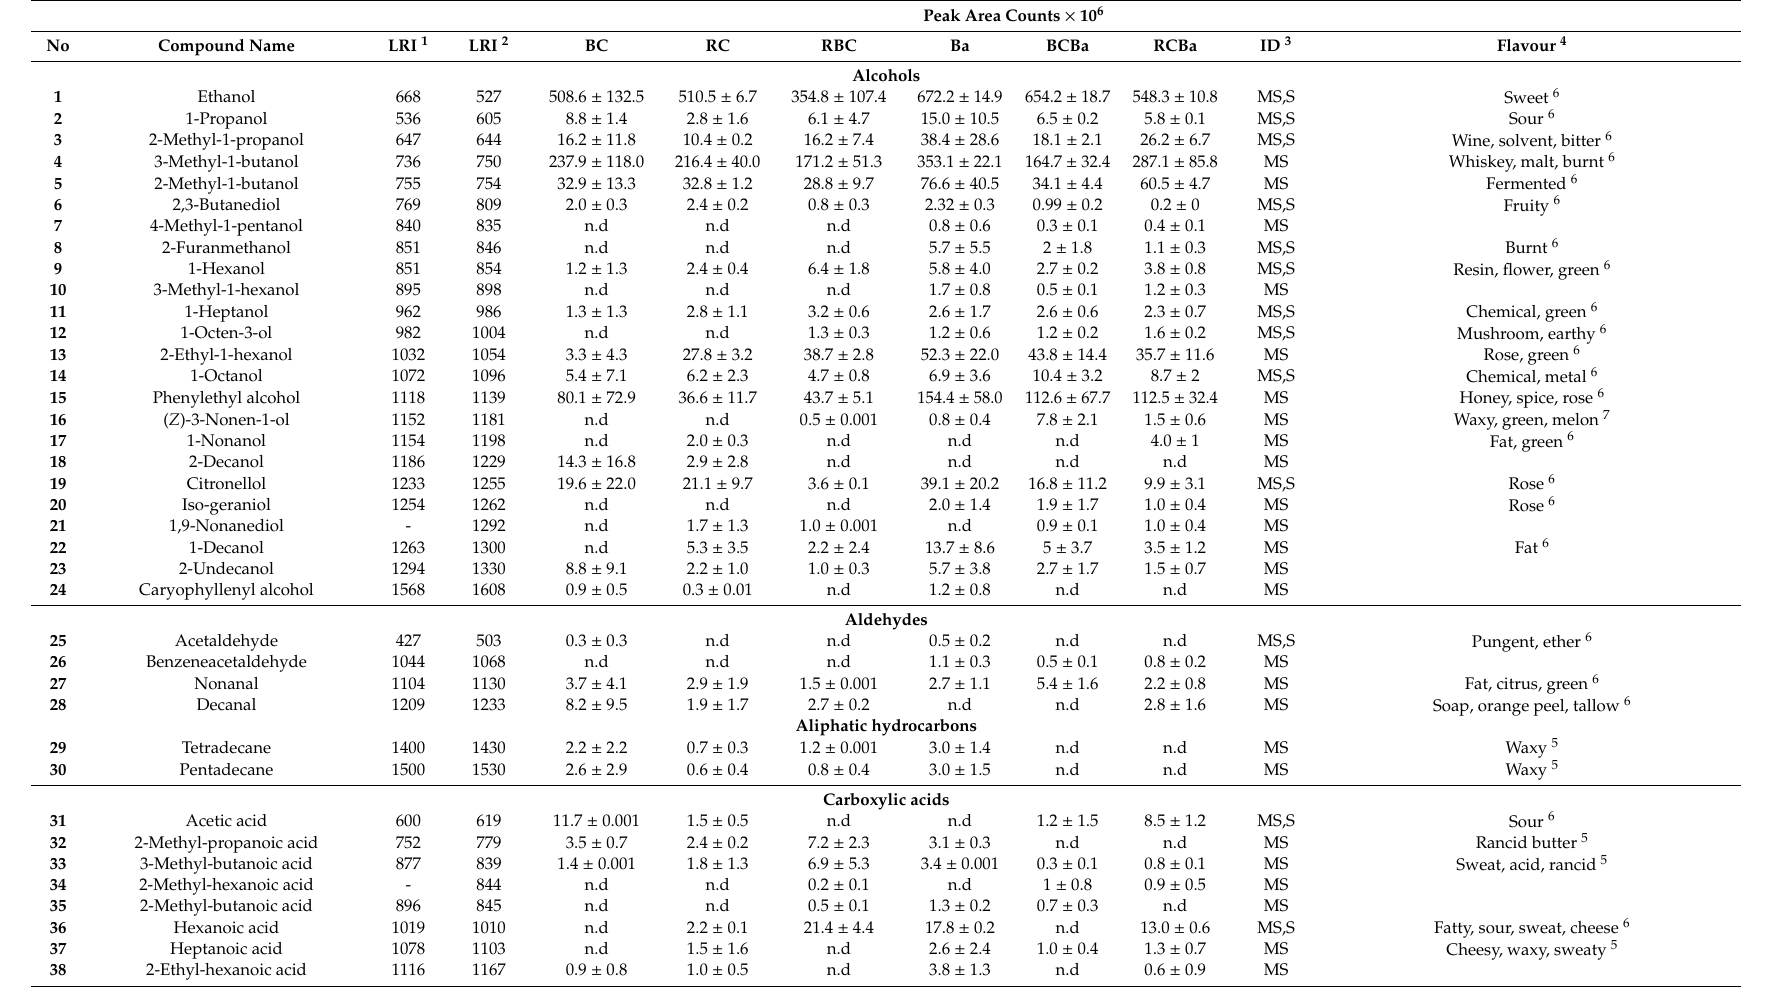
Table 2. Volatile compounds identified in all beer